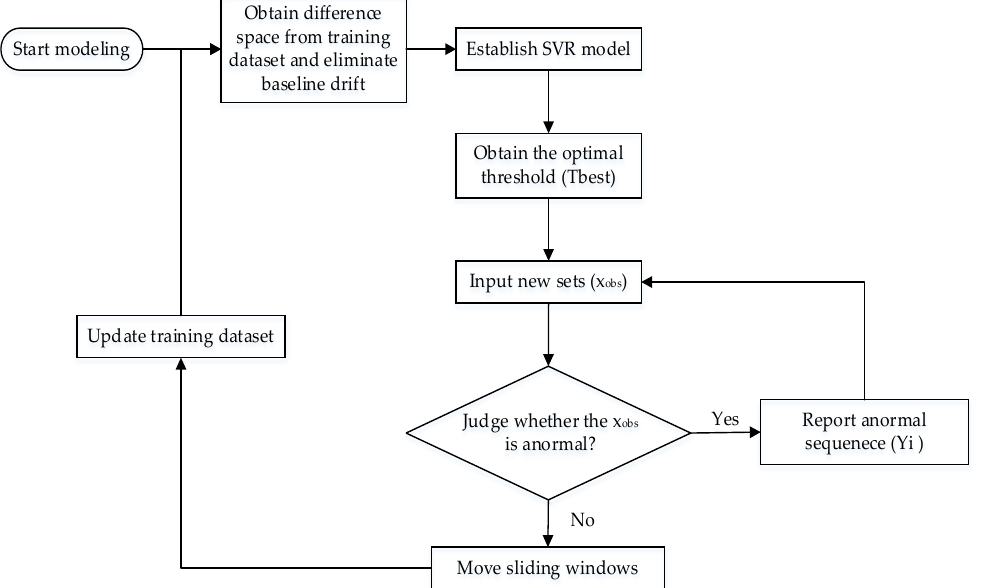
Figure 1. Modeling and detection flow chart.